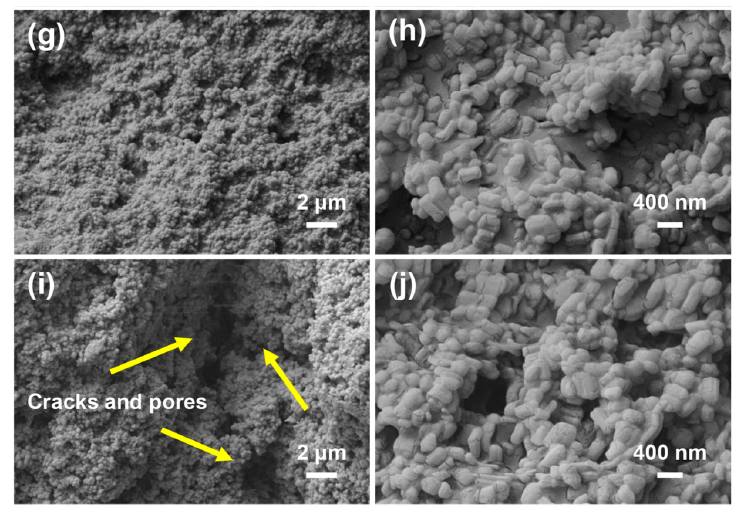
Figure 2. Microstructures of coatings with different PTFE mass fractions: ( a , b ) 0%; ( c , d ) 15.2%; ( e , f ) 34.9%; ( g , h ) 47.2%; and ( i , j ) 58.8%.